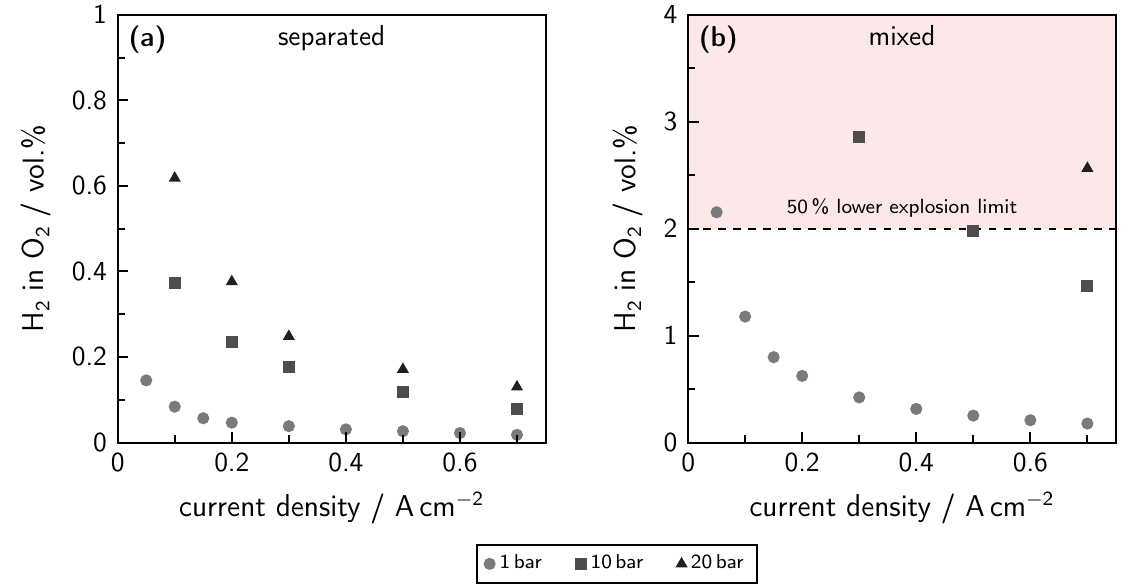
Figure 6. Anodic gas impurity (H 2 in O 2 ) in relation to the current density at different pressure levels for ( a ) separated and ( b ) mixed electrolyte cycles, at a temperature of 60 ◦ C, with an electrolyte concentration of approximately 32wt.% and an electrolyte volume flow of 0.35Lmin − 1